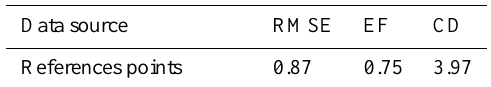
Table 2. Baseline values for sensitivity